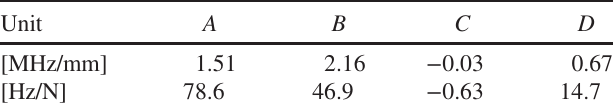
TABLE X. Frequency sensitivity to